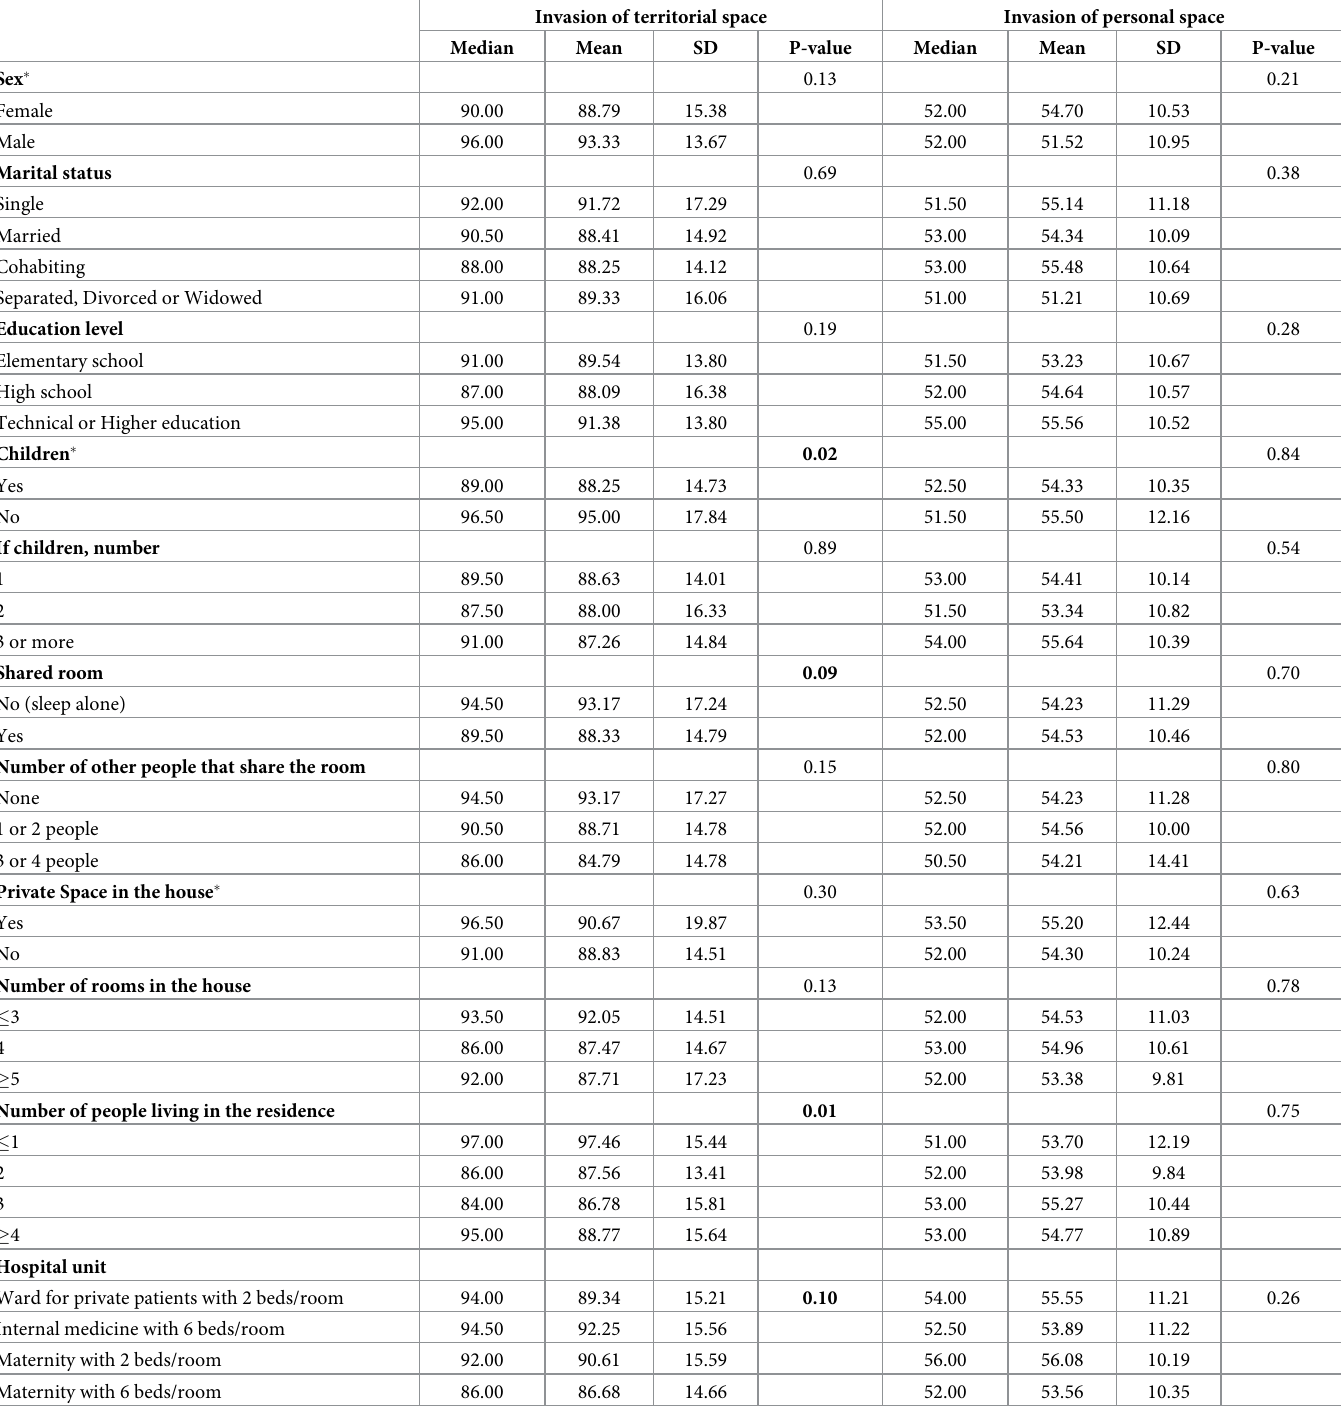
Table 4. Comparison of sample characteristics with the subscale scores of the Anxiety Due to Territory and Space Intrusion